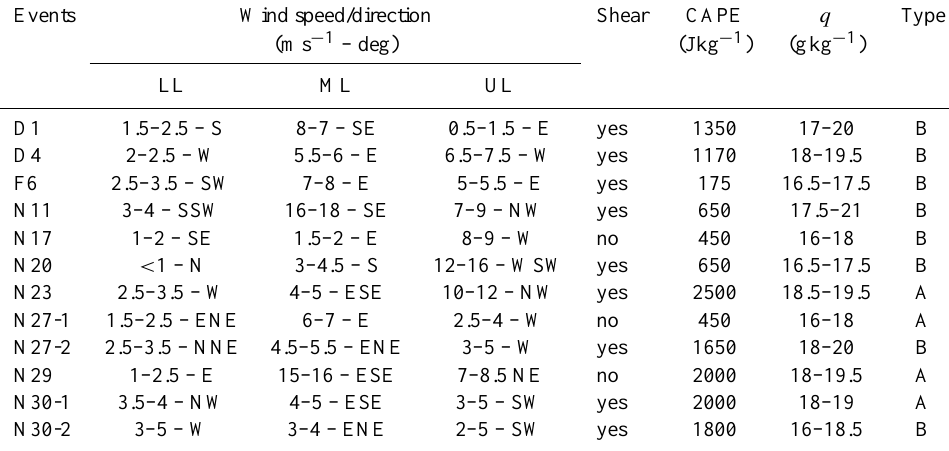
Table 1. Meteorological characteristics of the Hector events extracted from ECMWF analysis at 00:00UTC (09:30LST) for all the single and first cells of the double-structure events (marked in the table as 1) and at 06:00UTC (15:30LST) for the second cells (marked in the table as 2). In the heading LL stands for low level (950hPa), ML for medium level (700hPa) and UL for upper level (300hPa). Wind shear is denoted by “yes” if there is a change of wind direction between LL and ML. Events Shear